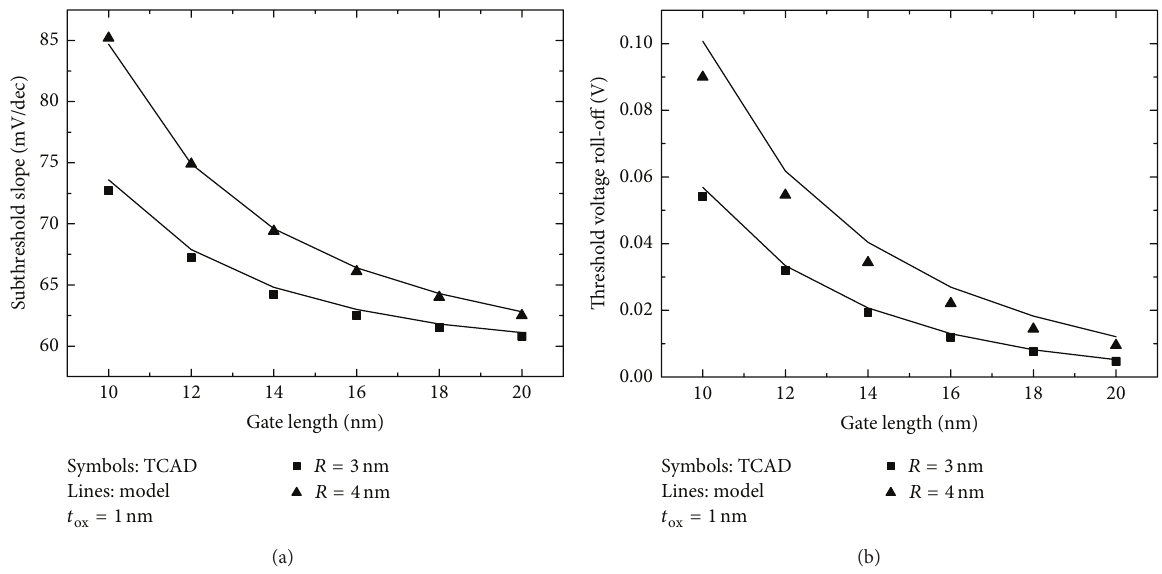
Figure 7: Dependence of (a) subthreshold slope and (b) threshold voltage roll-off on the gate length for different nanowire radii calculated from compact model and TCAD simulation. Drain bias is 0.05 V. Device parameters, except gate length, are listed in Table